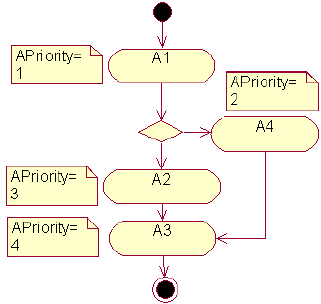
Fig. 8. Assigning APriority tag value for an activity diagram with merge